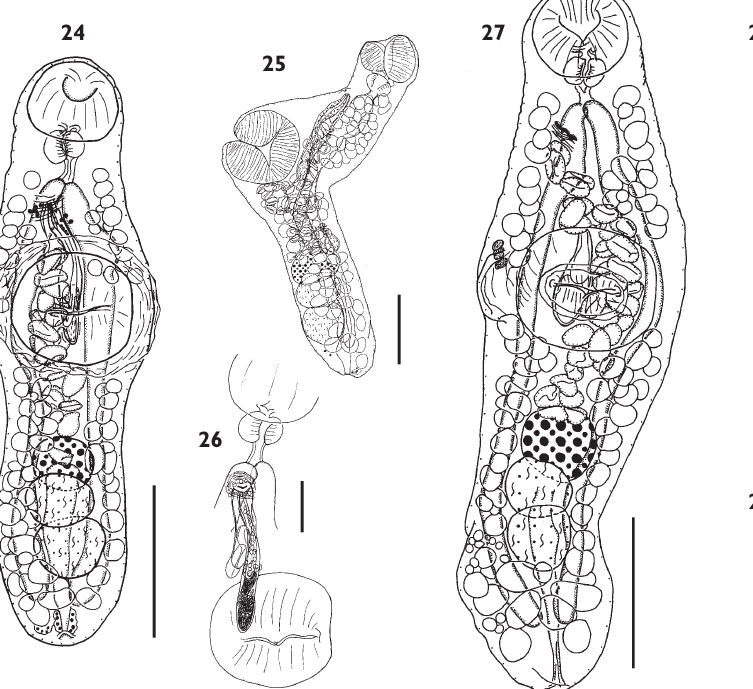
Figs 27-29. Macvicaria dextrocaula n. sp. ex No- tolabrus fucicola and N. parilus . 27. Whole-mount ventral view. 28. Dorsal distribution of vitelline follicles. 29. Dorsal distribution of vitelline follicles (ex N. parilus ). Scale bars : 27, 28, 29, 250 μm.